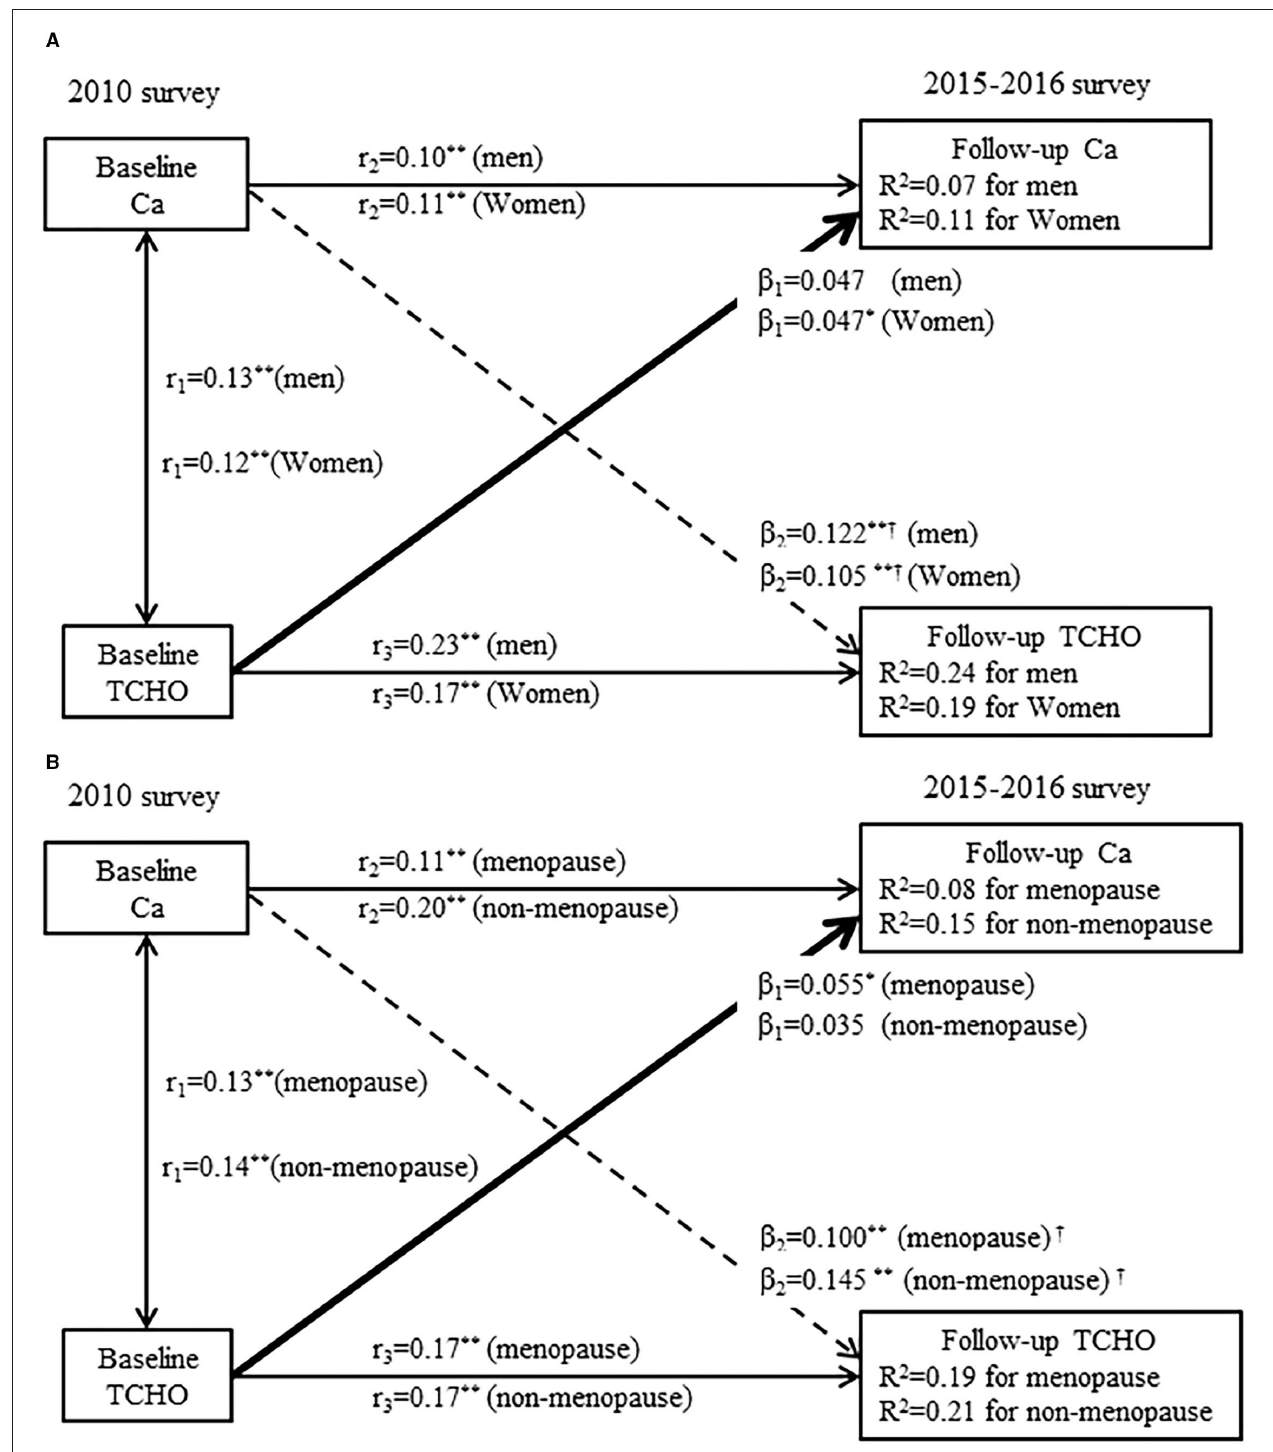
FIGURE 5 | (A) A cross-lagged path analysis of serum calcium and total cholesterol in men ( N = 1202) and women ( N = 2090); (B) A cross-lagged path analysis of serum calcium and total cholesterol in menopause ( N = 1053) and non-menopausal ( N = 1037). Adjusted for covariates (covariates included age, BMI, smoking, alcohol consumption, regular exercise, marriage, caloric intake, family history of CVD, TG, HDL-C, LDL-C, and drug use for hypertension or dyslipidemia); β 1 and β 2 are the cross-lagged path coefficients, r 1 represents synchronous correlations, r 2 and r 3 represent the tracking correlations, R 2 variance explained. *** P < 0.001 for the coefficients being different from